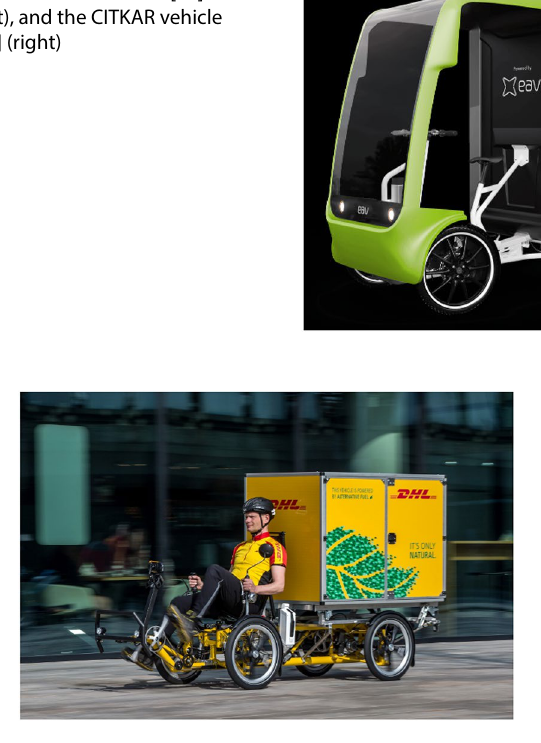
Fig. 4 The Armadillo vehicle [16]